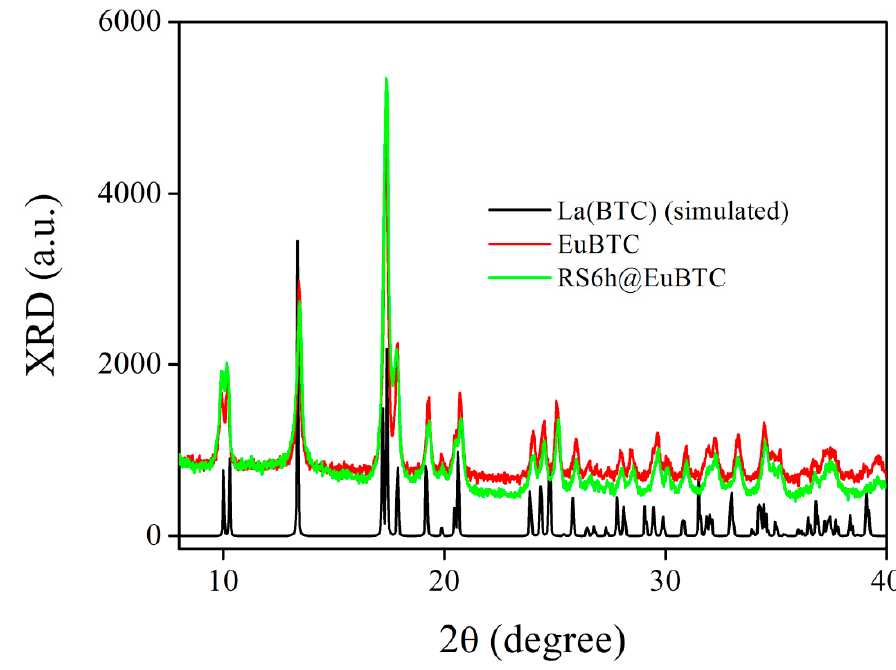
Figure 2. XRD curves of La(BTC)·6H 2 O, RS6h@EuBTC and EuBTC.